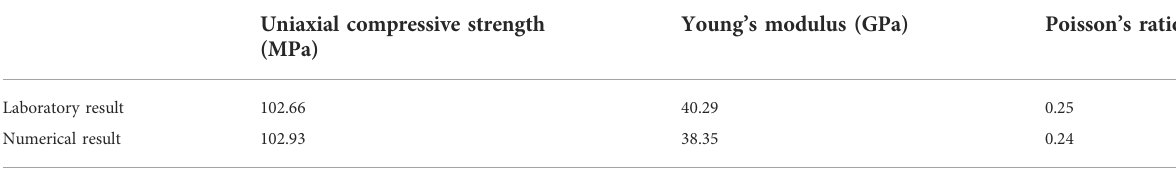
TABLE 2 Comparisons of the basic mechanical properties of the granite samples.